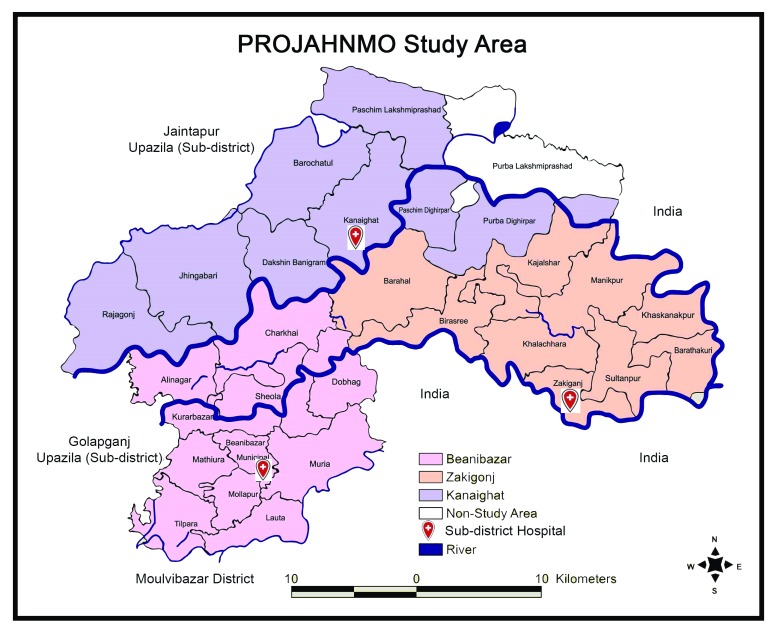
Study area.Pneumococcal Conjugate Vaccine impact assessment in Bangladesh.